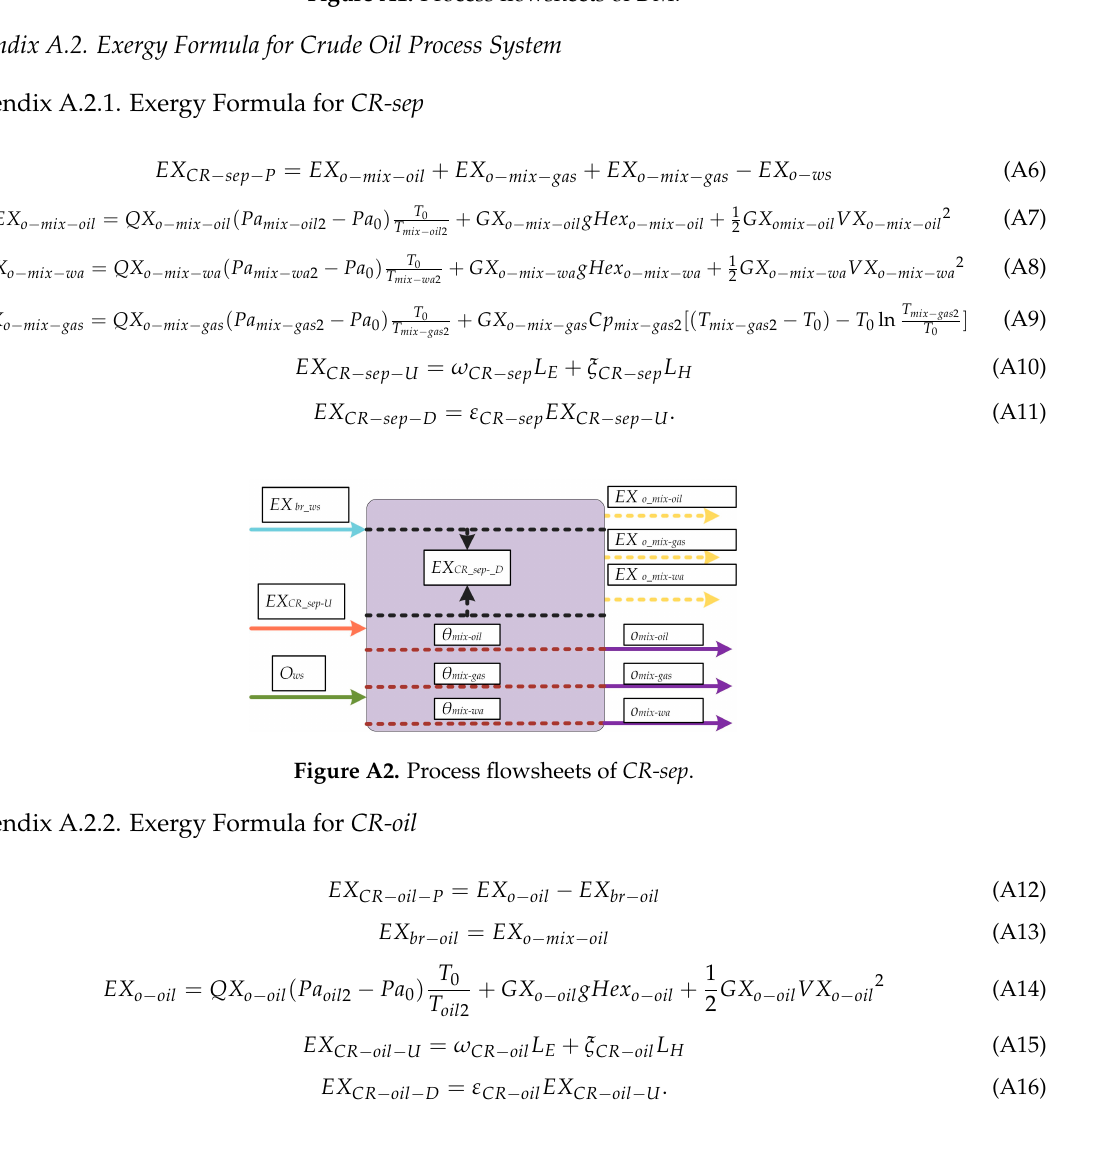
Figure A1. Process flowsheets of DM .